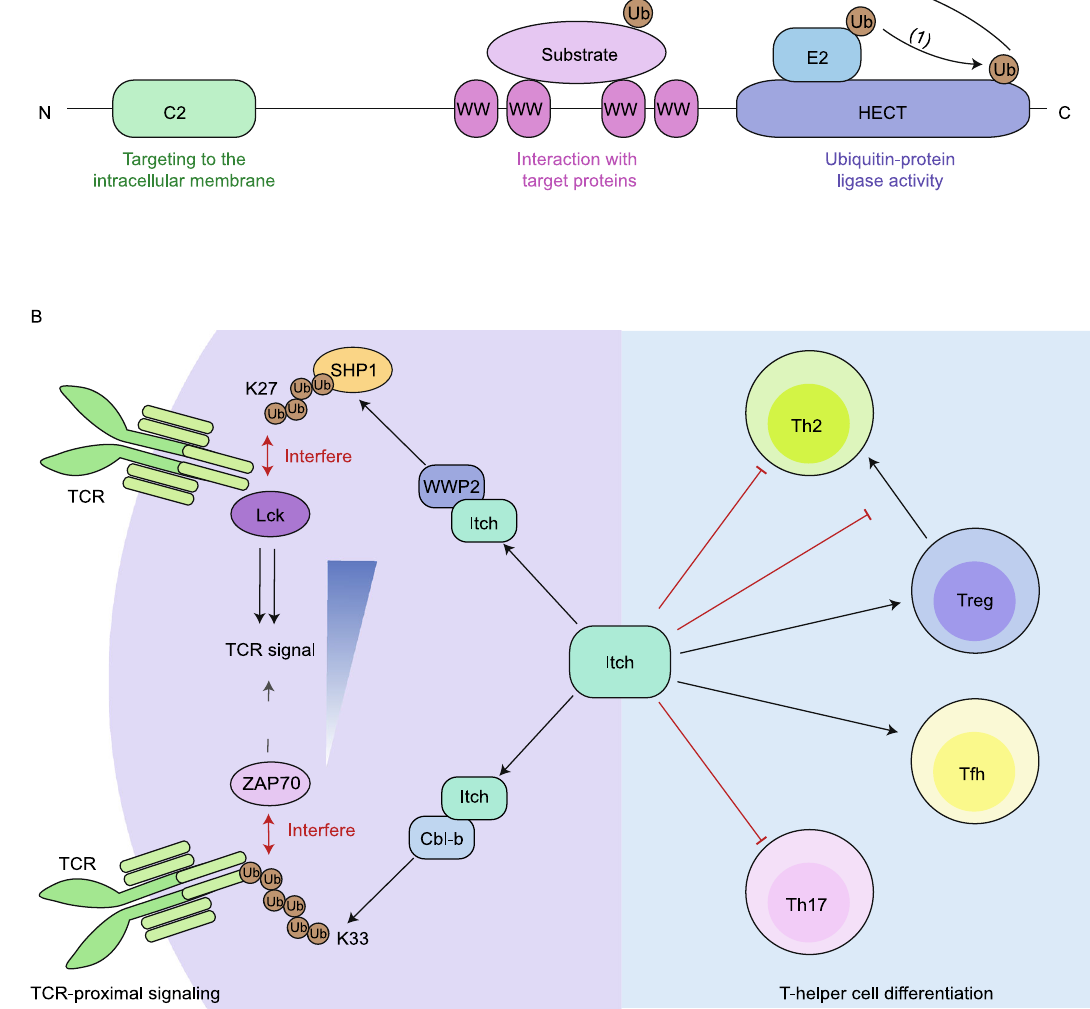
Figure 2. Itch and its role in T cells. (A) Schematic structure of Itch which shows the N-terminal C2 domain, the 4 WW domains for substrate recruitment, and the HECT ligase domain for the E2-ubiquitin binding and for the transfer of ubiquitin to the substrate. (B) Distinct functions of Itch in T cells. Itch cooperates with other E3 ligases to regulate TCR-proximal signaling (left). Itch regulates the differentiation of different T helper subsets